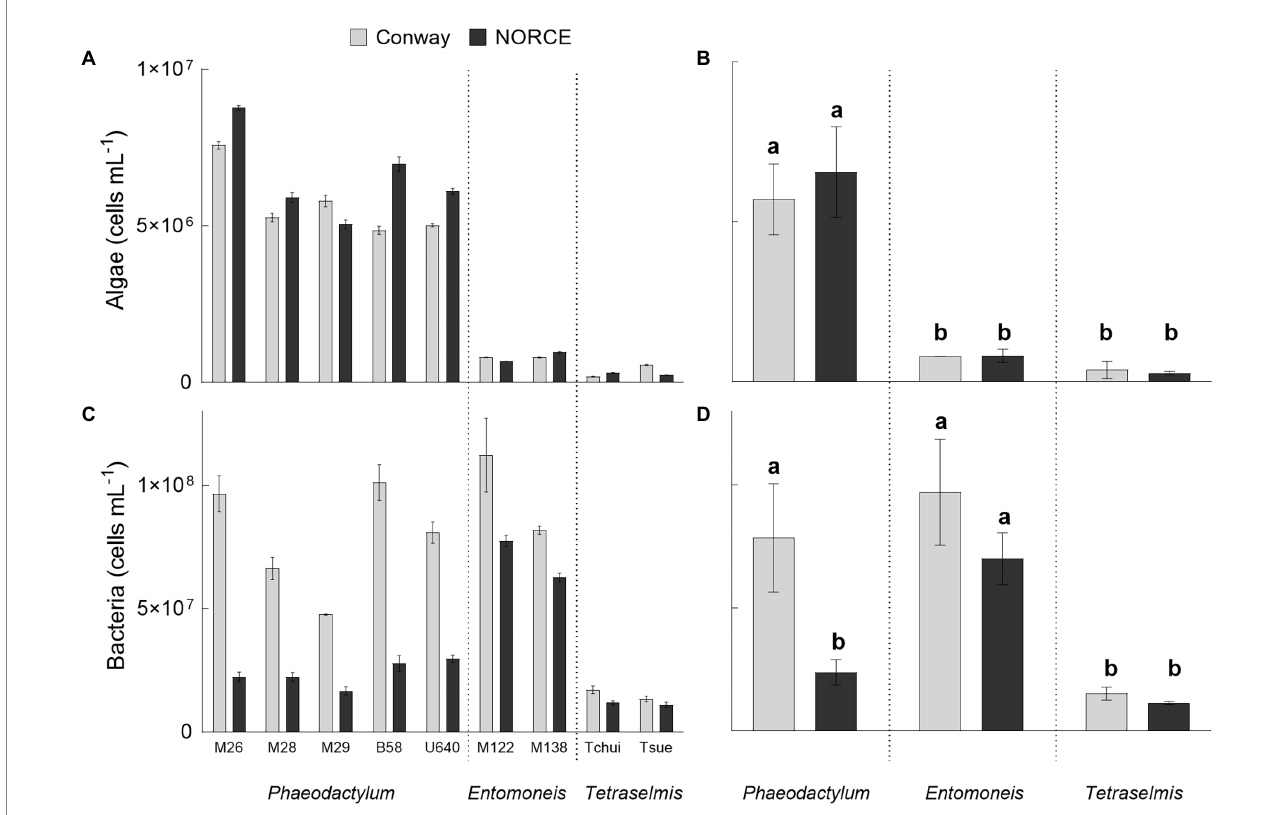
FIGURE 3 Algal and bacterial cell counts for stock cultures of nine microalgal strains in two different media (Conway and NORCE). (A) Algal cell concentration for each culture. (B) Average algal cell concentration for cultures grouped by microalgal genera and medium. (C) Bacterial cell concentration for each culture. (D) Average bacterial cell concentration for cultures grouped as in B . (A,C) Show average and standard deviation of three measurement replicates. (B,D) Show average and standard deviation of the different cultures. Same letters above the bars indicate no significant differences ( p <